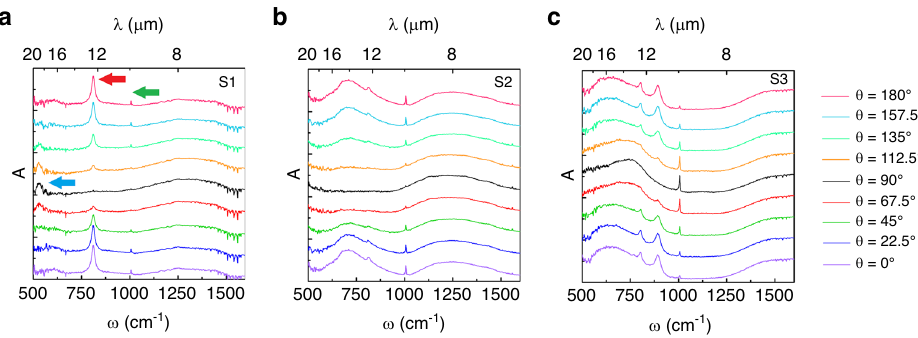
Fig. 4 Experimental polarization-dependent absorption spectra of α -MoO 3 . Polarization-dependent absorption spectra of fabricated samples with different Ge and α -MoO 3 thickness ( t Ge and t MO , respectively), schematically illustrated in Fig. 1d with thick Au, ( a ) S1, t Ge = 0.42 μ m and t MO = 0.15 μ m, ( b ) S2, t Ge = 0.42 μ m and t MO = 0.95 μ m, and ( c ) S3, t Ge = 0.85 μ m and t MO = 1.1 μ m. Incident polarization ( ϕ i ) is varied (bottom to top) from 0° to 180° in 22.5° revolution and illumination angle θ = 25° from FTIR. The green, red and blue arrows in ( a ) emphasize, respectively the OPh z , OPh x , and OPh y . The peaks observed in each sample are marked on Fig.